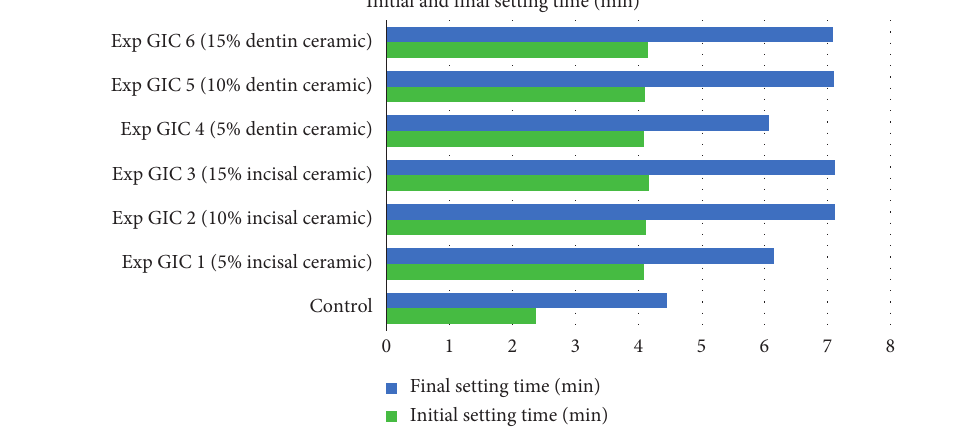
Figure 6: Setting time of samples in Group 2.